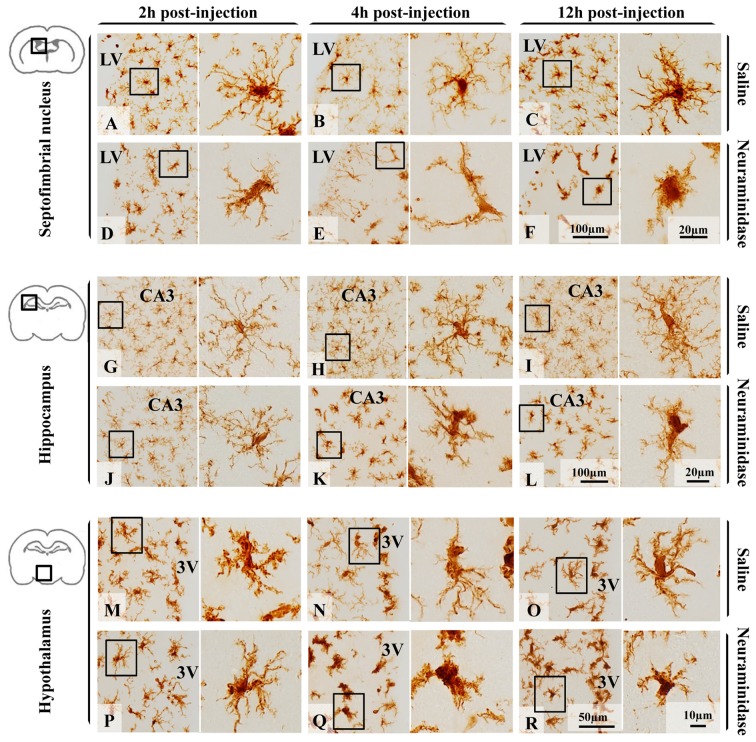
Polymorphism of microglial cells from different brain areas in basal conditions and after an inflammatory stimulus. Microglia morphology, evidenced by the size and form of the soma, and the presence and the length of secondary/tertiary branches, remained unchanged 12 h after saline administration within the LV in the three areas studied: the septofimbrial nucleus (A–C), the hippocampus (G–I) and the hypothalamus (M–O). Neuraminidase injection resulted in morphological changes of microglial cells in the septofimbrial nucleus (D–F),the hippocampus (J–L) and the hypothalamus (P–R). Only 2 h after neuraminidase (NA) injection, cells in the septofimbrial nucleus showed a larger soma (D), and thicker primary branches after 12 h (F) compared to the pairwise sham samples (A–C). In basal conditions microglia located in the hippocampus (G–I) exhibited a higher degree of ramification compared to cells in other areas (A–C,M–O). These profuse ramifications appeared slightly decreased 2 h after NA injection (J), and clearly reduced 4 h (K) and 12 h (L) later. Microglia in the hypothalamus presented a different shape to that located in the hippocampus or septofimbria, with low homogeneity, a large soma and thick branches that could be observed in samples from saline treated rats (M–O). A significant drop in branch length was observed 4 h (Q) and 12 h (R) after NA injection. LV, lateral ventricle; CA3, field CA3 of the hippocampus; 3V, third ventricle.